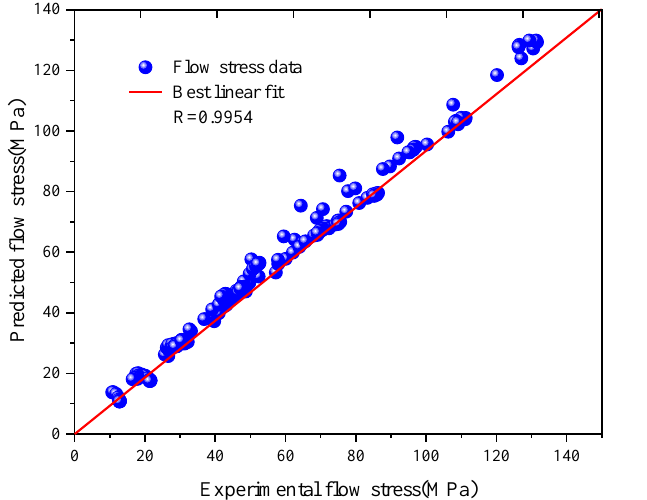
Figure 9. Correlation analysis between experimental values and constitutive equation prediction